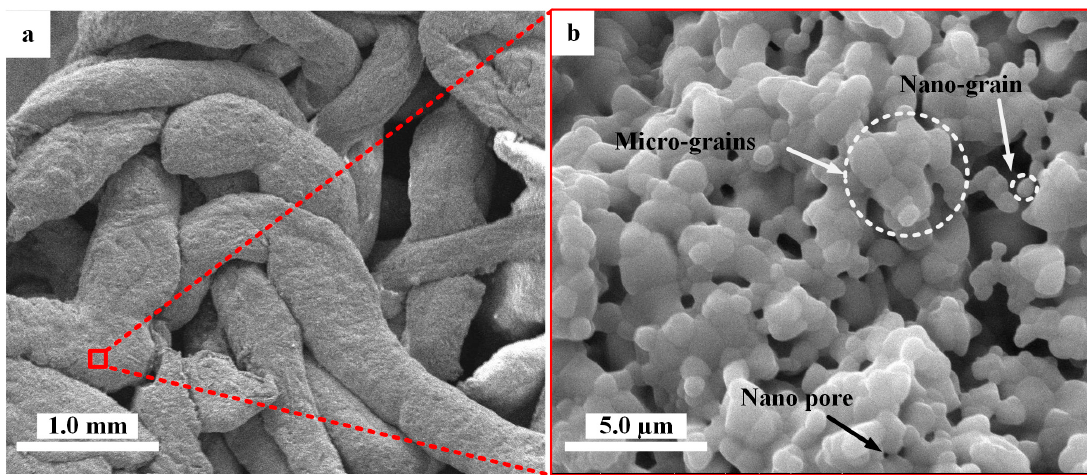
Figure 3. Scanning electron microscopy (SEM) photographs of the typical morphology of as-sintered HA scaffolds: ( a ) typical morphology of HA fiber scaffold and ( b ) the surface of HA scaffold fiber with micropores.